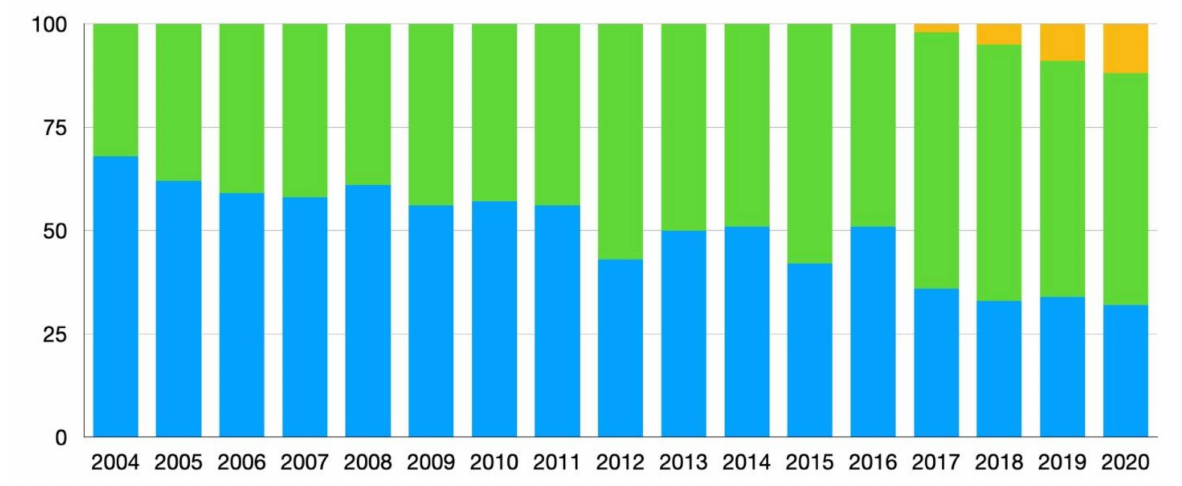
Figure 1. Changes in percentages of surgical approach used from 2004–2020 of all cases of liver resection for colorectal liver metastases (CRLM) after matching. Blue = open liver resection (OLR), green = laparoscopic liver resection (LLR), yellow = robotic liver resection (RLR). When unmatched patients who had undergone OLR were compared to the RLR, ASA class and presence of cirrhosis were significantly higher in the RLR group, p = 0.02 and